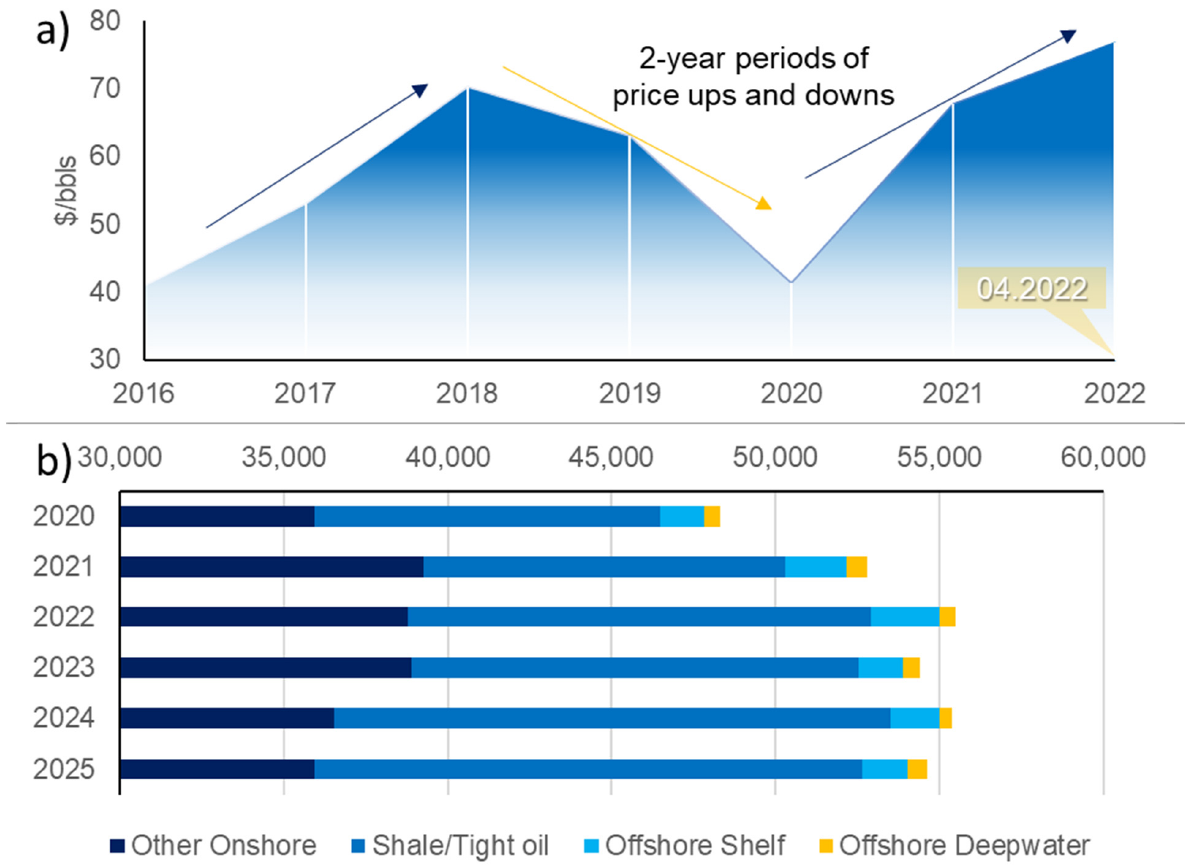
Figure 3. The cost of oil and changes in drilling volumes: ( a ) the cost of Urals oil according to VYGON Consulting; ( b ) global changes in well drilling and completion, pcs. [17,18].